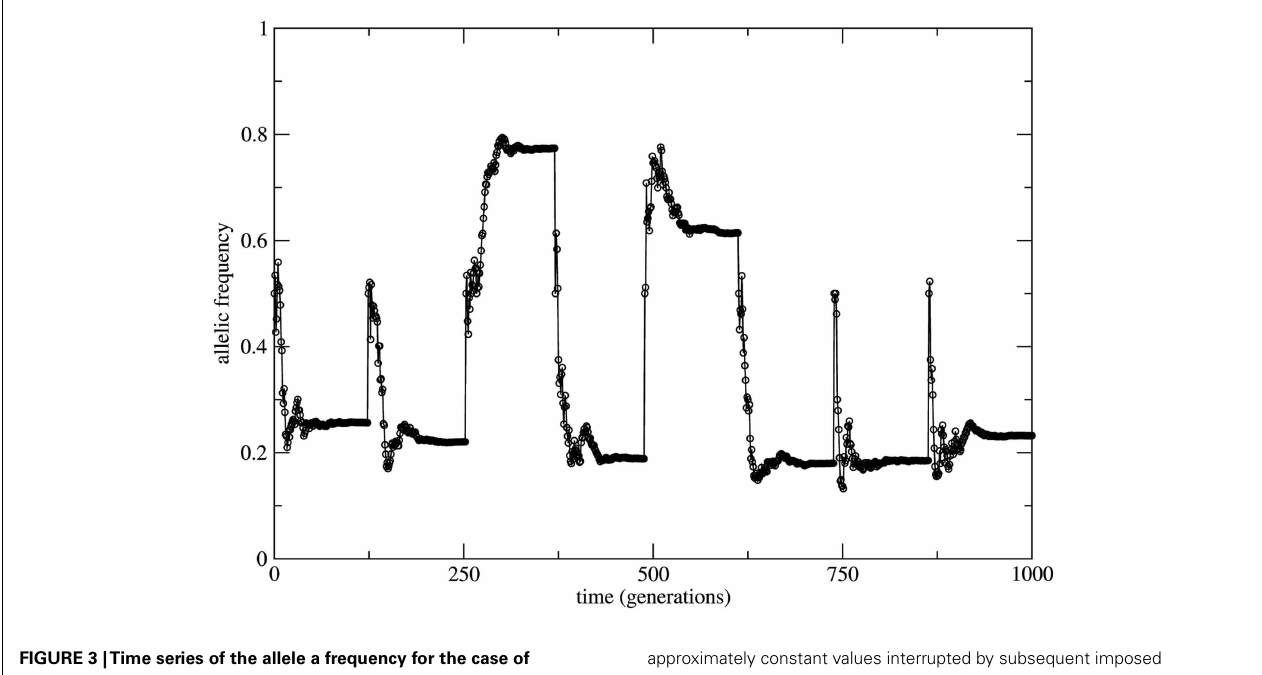
FIGURE 3 |Time series of the allele a frequency for the case of random mating. To highlight the role of neutral dynamics an initial population with the profile N aa = N AA = 10 and N Aa = 20 (allele frequency f a = 0.5) grows till a fixed size of N = 3.0 × 3.0 × 10 7 individuals. After reaching this maximal population size the allele frequency f a reaches